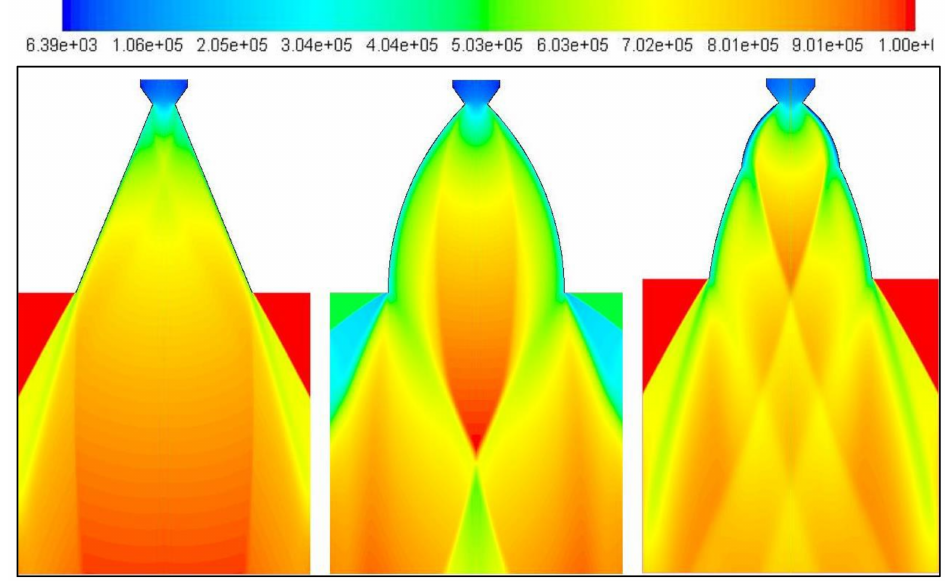
Figure 28. Pressure contours for conical, bell nozzle, and dual bell nozzle at 80,000 ft and Mach 4.5.